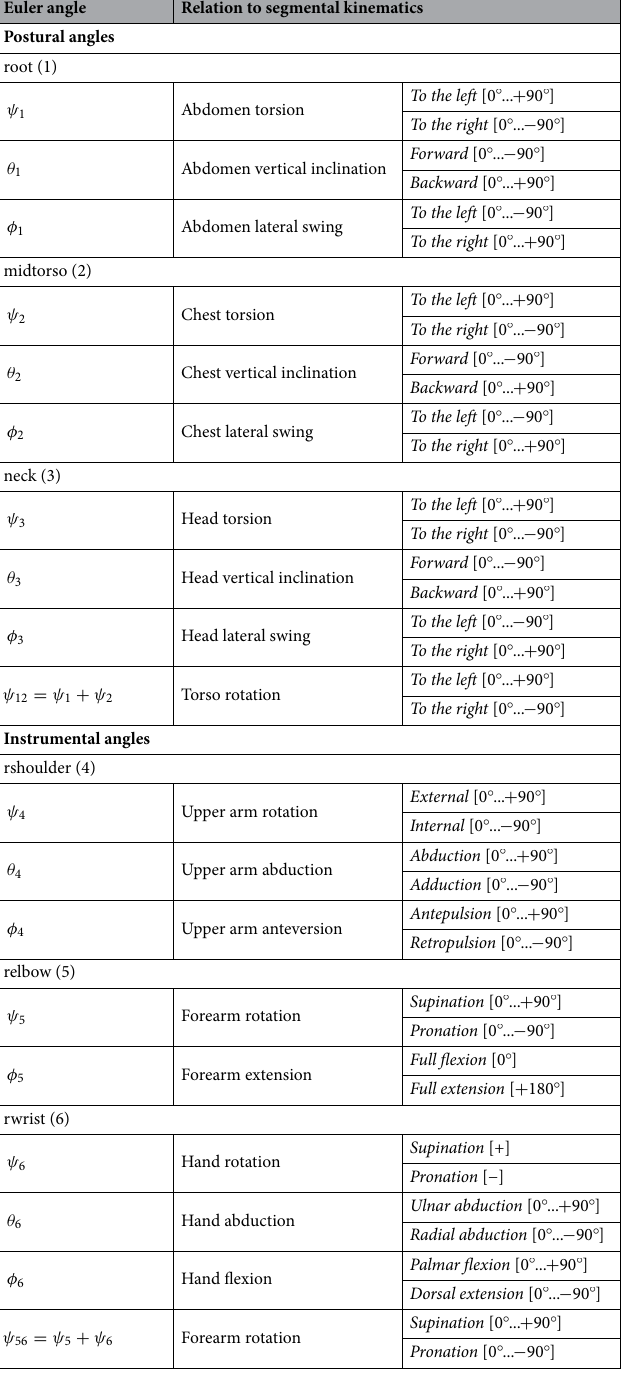
Table 1. Anatomic variables described as joint-related Euler angles { ψ , θ , φ } of the segmental kinematics. The sign of each angle depends on its rotational direction that can be established from the resting kinematic model (cf Fig. 1a) by following the right-hand